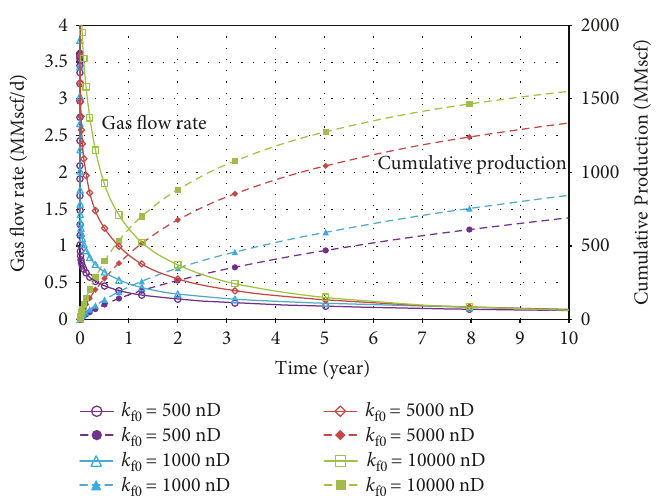
Figure 8: Impact of natural fracture permeability on gas